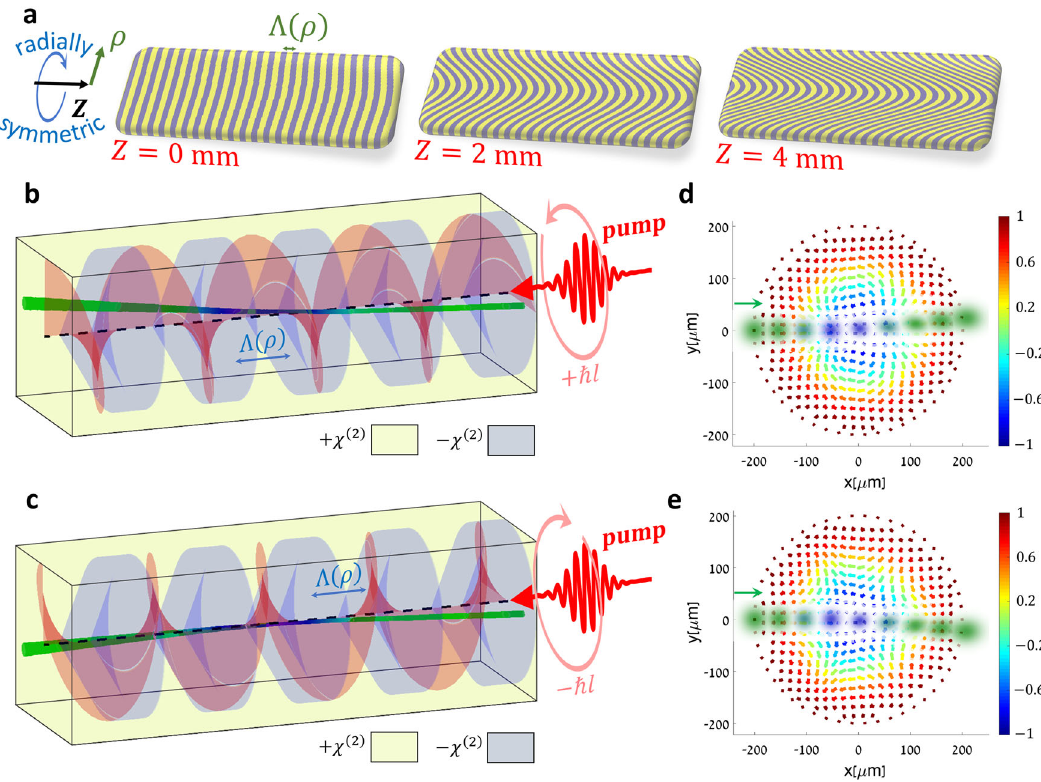
Fig. 5 All-optical angular-momentum control of the topological Hall effect for light. a Cross section of the three-dimensional nonlinear photonic crystal (cid:4) (cid:5) along the optical axis, showing the radial variation in the modulation period, Λ ρ ( ρ denotes the radial coordinate with respect to the optical axis). The (cid:4) (cid:5) nominal quasi-phase-matching period Λ ρ is 10 : 24 μ m, and it changes between 10 : 33 μ m at the crystal center, to 10 : 15 μ m at the edges. Note that in this (cid:4) (cid:5)(cid:12) (cid:13)(cid:14) (cid:15) case the required χ 2 ð Þ pattern is rotationally symmetric, given by χ 2 ð Þ ¼ sign cos 2 π Z = Λ ρ . b , c a quadratic ( χ 2 ð Þ ) nonlinear photonic crystal with a radially symmetric variation in the periodicity is illuminated by a broad pump beam carrying orbital angular momentum of ± (cid:1) hl (red). The pump beam pro fi le and phase front, together with the 3D NLPC structure, induce a topologically nontrivial magnetization texture, with opposite skyrmion numbers S ¼ ± l . As a result, an incident idler beam is de fl ected according to the topological Hall effect. d , e Simulation results for the optically-controlled topological Hall effect, for a pump beam carrying OAM of d þ 2 (cid:1) h and e (cid:2) 2 (cid:1) h , with a waist of w 0 ¼ 100 μ m ( S ¼ ± 2, n ¼ l ¼ ± 2 ; η ¼ 0 ; R ¼ 200 μ m and beam angle of 1 : 1 (cid:3) ). The idler beam is de fl ected in opposite directions according to the skyrmion